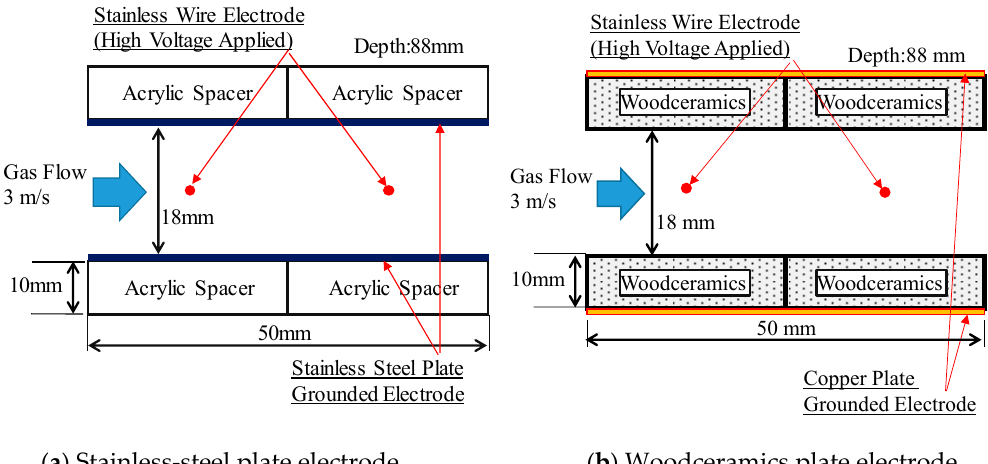
Figure 10. Side view of each electrode structure. In the corona discharge electrode configuration, the grounded electrode was either a ( a ) stainless-steel grounded electrode or ( b ) woodceramics grounded electrode. Each grounded plate electrode structure was placed such that its surface was the same distance from the wire electrode.